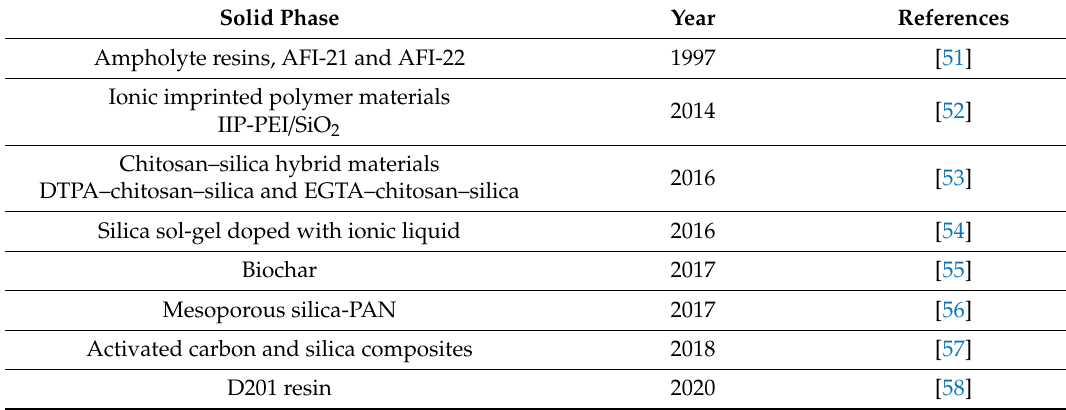
Table 3. Previous studies to recover scandium by solid-phase extraction